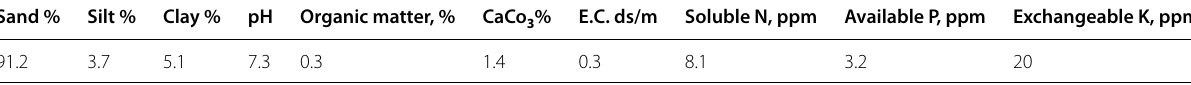
Table 1 Mechanical and chemical analysis of experimental soil Sand % Silt % Clay